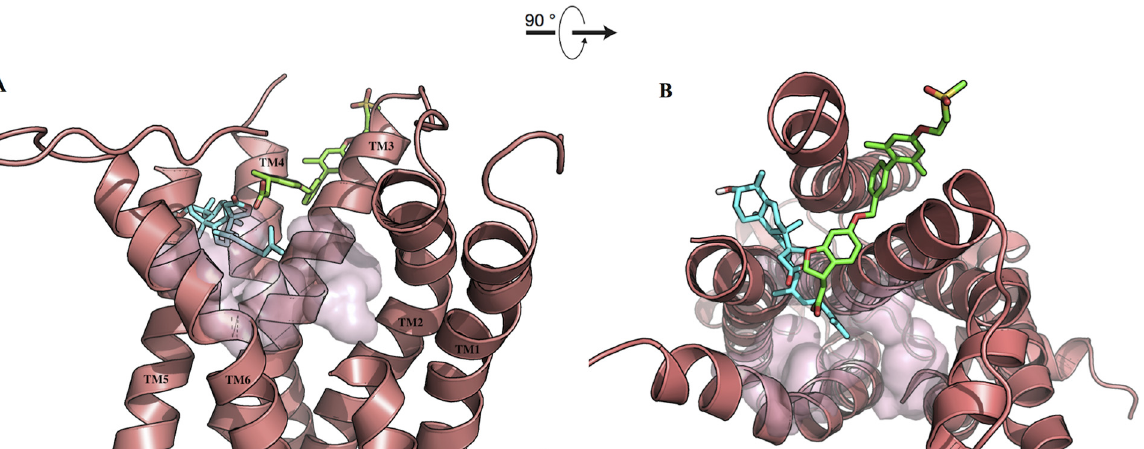
Fig 8. Superposition of ebelin lactone (cyan) in complex with the 5-HT 2A receptor and TAK-875 (green) in complex with free-fatty acid receptor 1. A. Front view and B. Top view (from the extracellular surface). Superposition of ebelin lactone in complex with the 5-HT 2A receptor from the docking studies and the allosteric modulator TAK-875 in complex with the free-fatty acid receptor 1 from the crystal structure (PDB code: 4PHU) shows both ligands bound to cavities in between the transmembrane helices suggesting ebelin lactone could be a 5-HT 2A allosteric modulator. The transparent surface represents the orthosteric site of the 5-HT 2A receptor. For the purpose of clarity, some of the loops and transmembrane helix are not